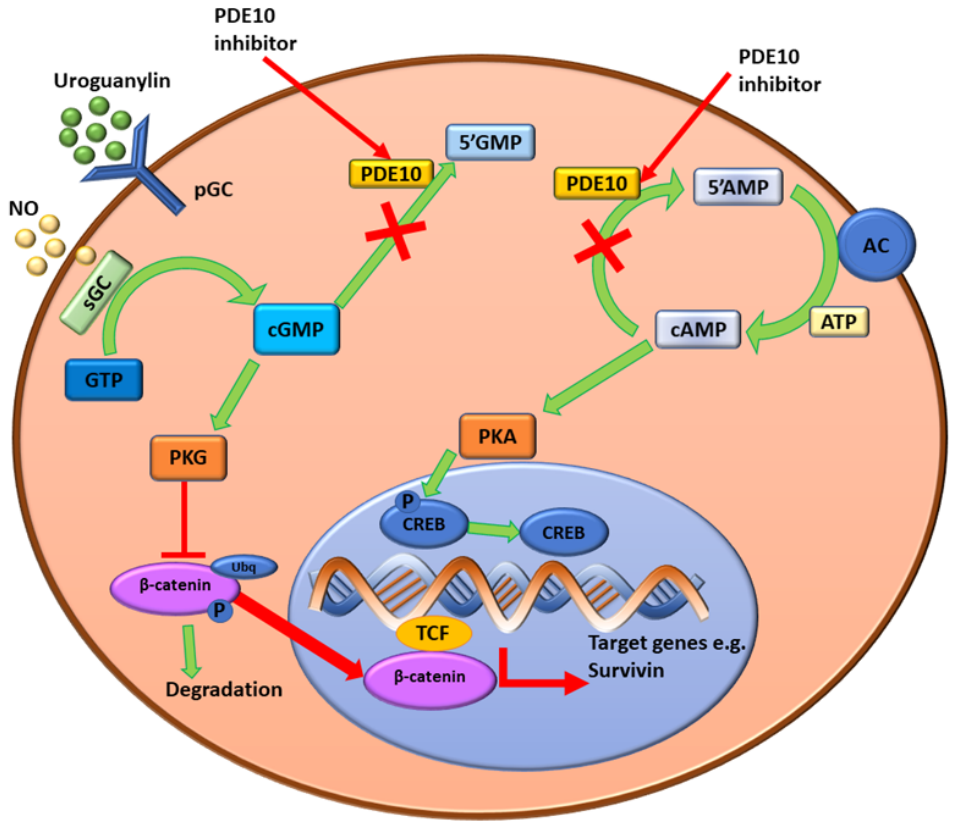
Figure 2. Schematic diagram for the mechanisms underlying the anti ‐ tumor effects of PDE10 inhibition in colon tumor cells. Intracellular cGMP levels are increased due to the inhibition of PDE10A preventing the breakdown to 5 ′ GMP. This activates PKG, which results in the suppression of the expression of β‐ catenin and inhibits T ‐ cell factor (TCF) transcription of target genes (e.g., survivin). The inhibition of PDE10A prevents breakdown of cAMP to 5 ′ AMP, AC enzymes continue to form cAMP using ATP causing cAMP levels to increase [46]. cAMP activates PKA which phosphorylates CREB. CREB can then activate downstream signaling pathways that either stimulate or inhibit